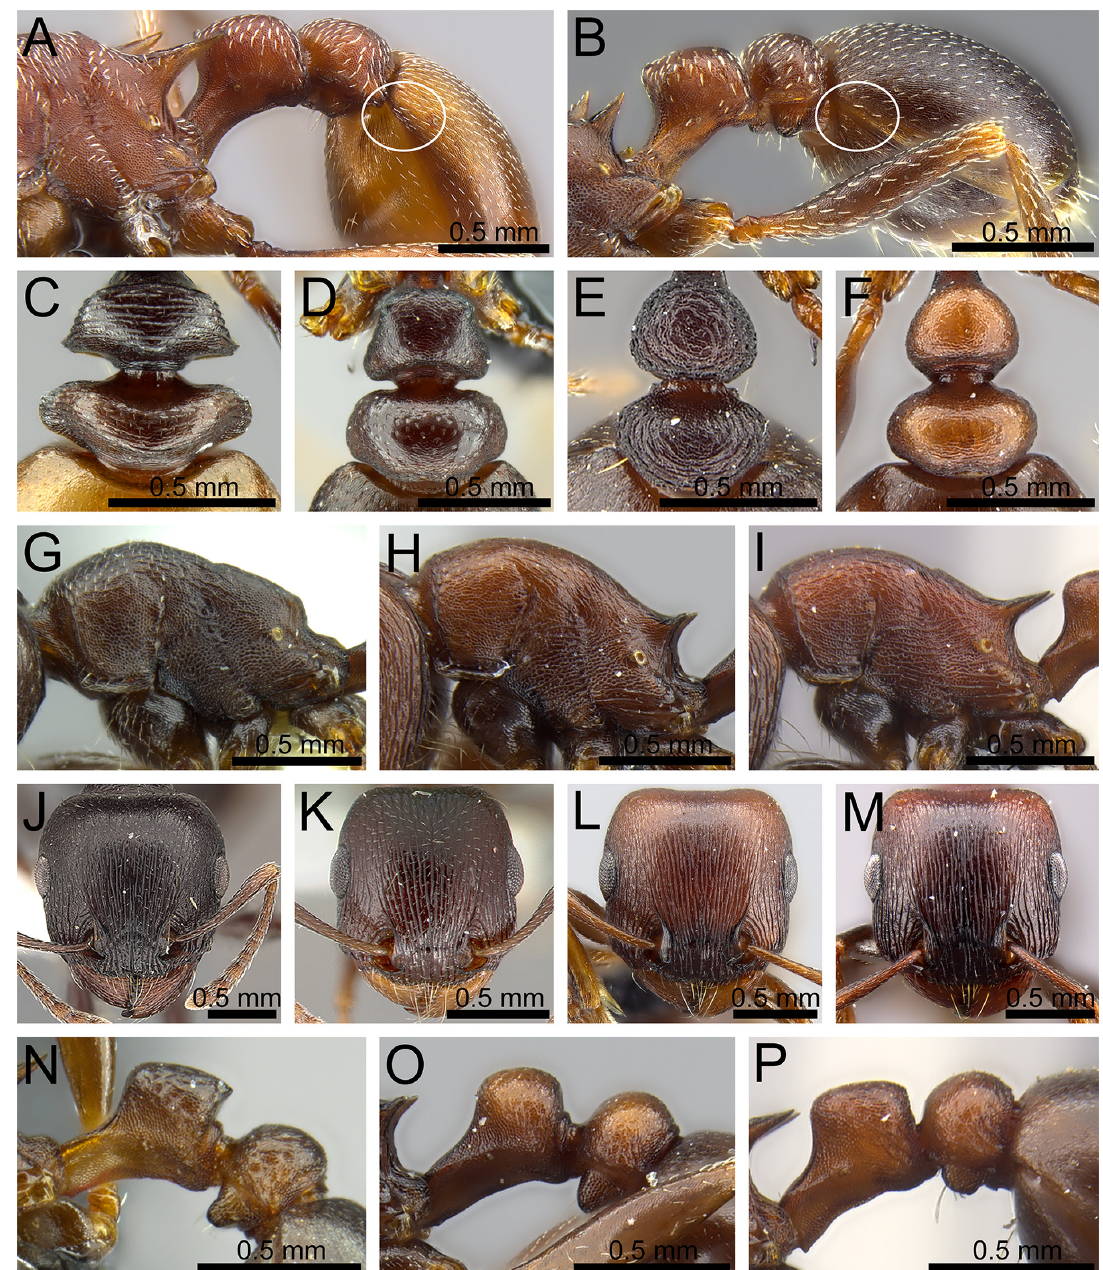
Fig. 3. A–B . Waist segments and gaster oblique lateral view. A. T. setuliferum Emery, 1895 (MCZ_ ENT00512567). B. T. clunum Forel, 1913 (CASENT0764600). C–F . Waist segments in